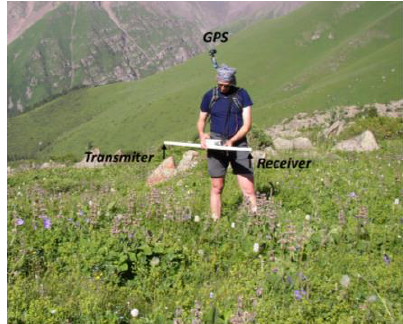
Figure 12. The electromagnetic apparatus GEM-2